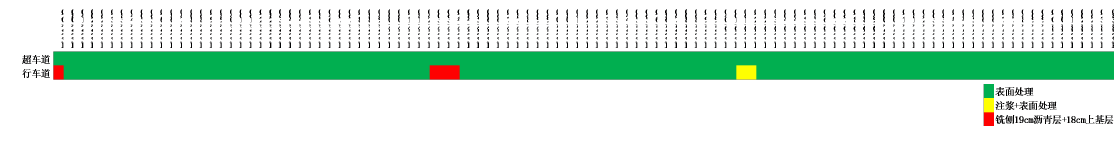
Fig. 5 Distribution map of the pavement diseases treatment plan of K3252 + 020 ∼ K3258 + 360 section of the expressway with a reconstruction and extension in Guangdong